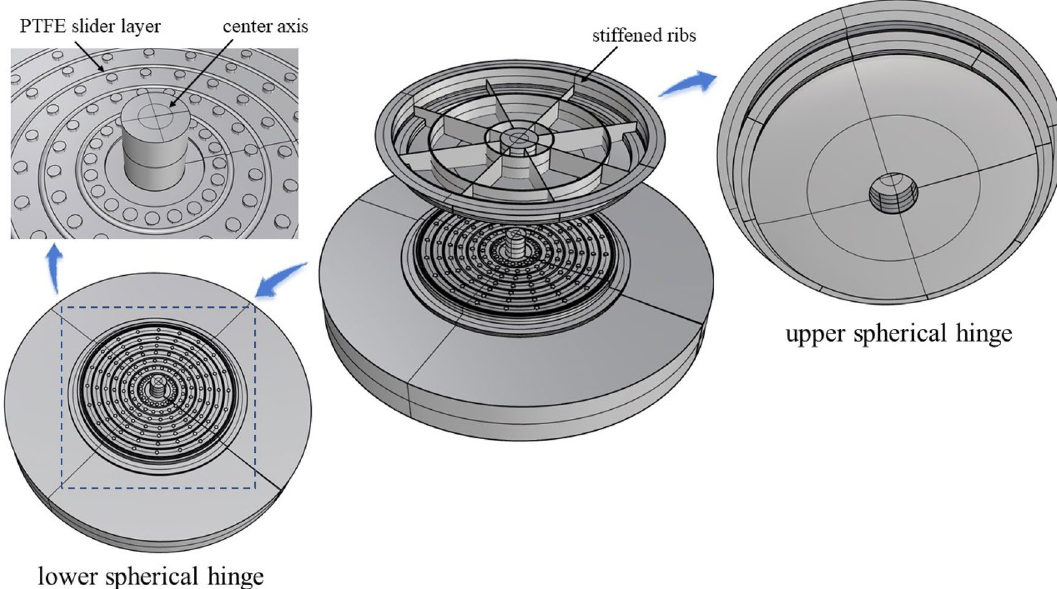
Figure 3. Diagram of spherical hinge structure.